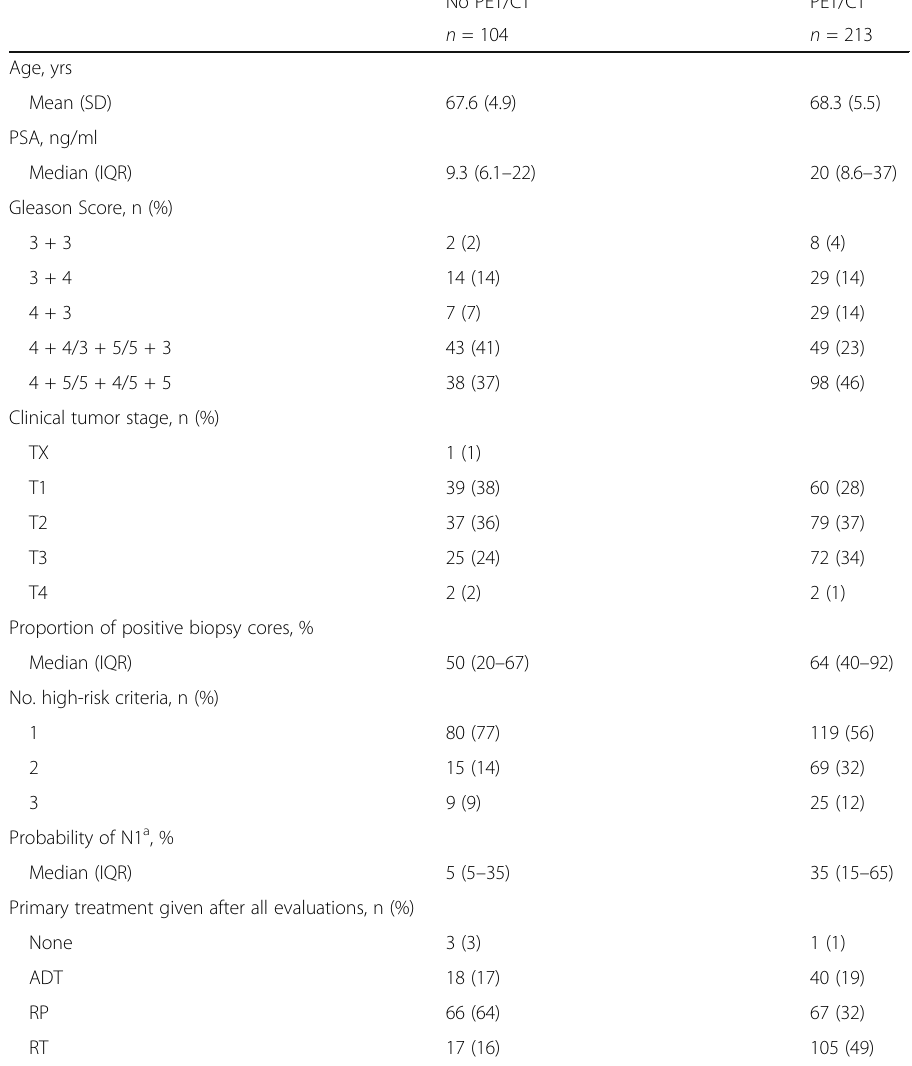
Table 1 The clinical characteristics of the men included in the study who were initially considered for curative treatment, categorized by whether choline PET/CT was performed or